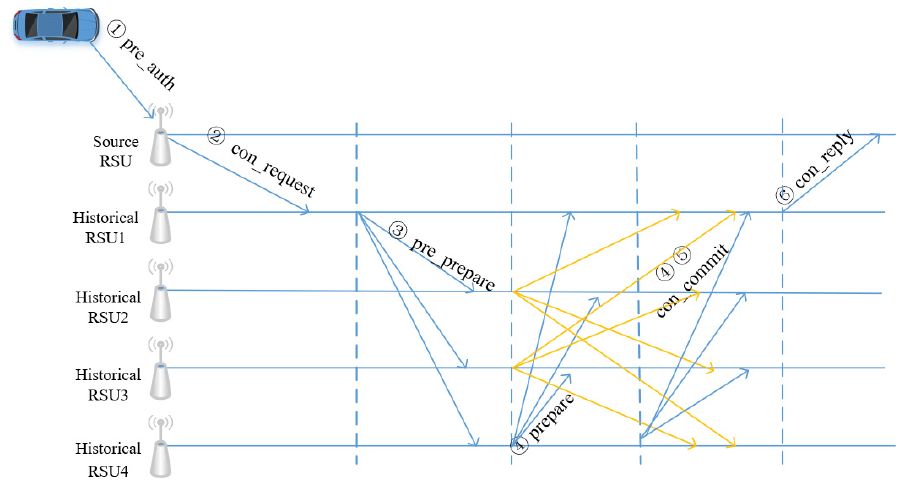
Figure 3. Consensus pre-authentication process.